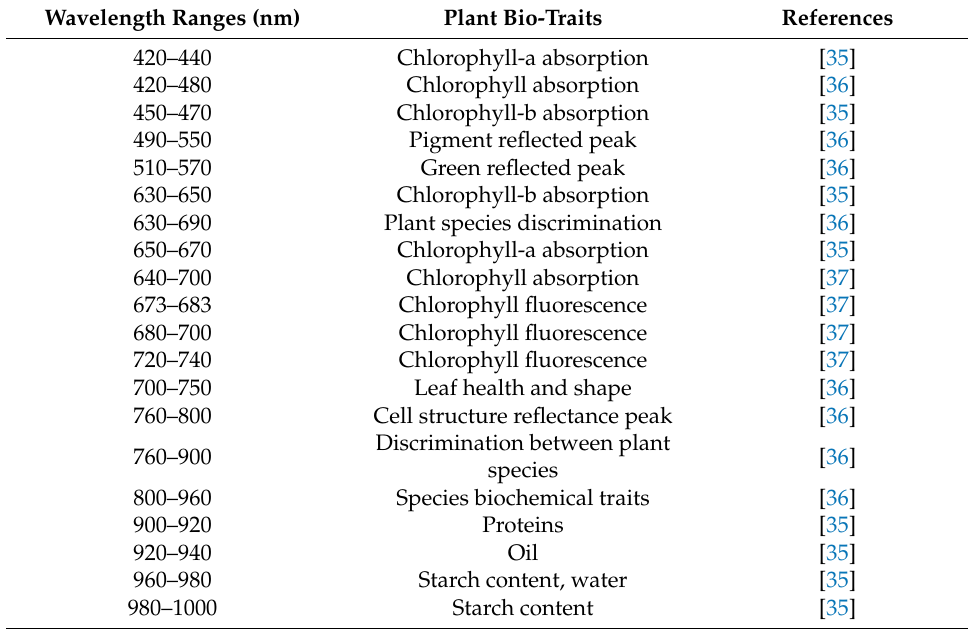
Table 1. The specific wavelength ranges of plant biological traits used in the present as potential indicator of plant